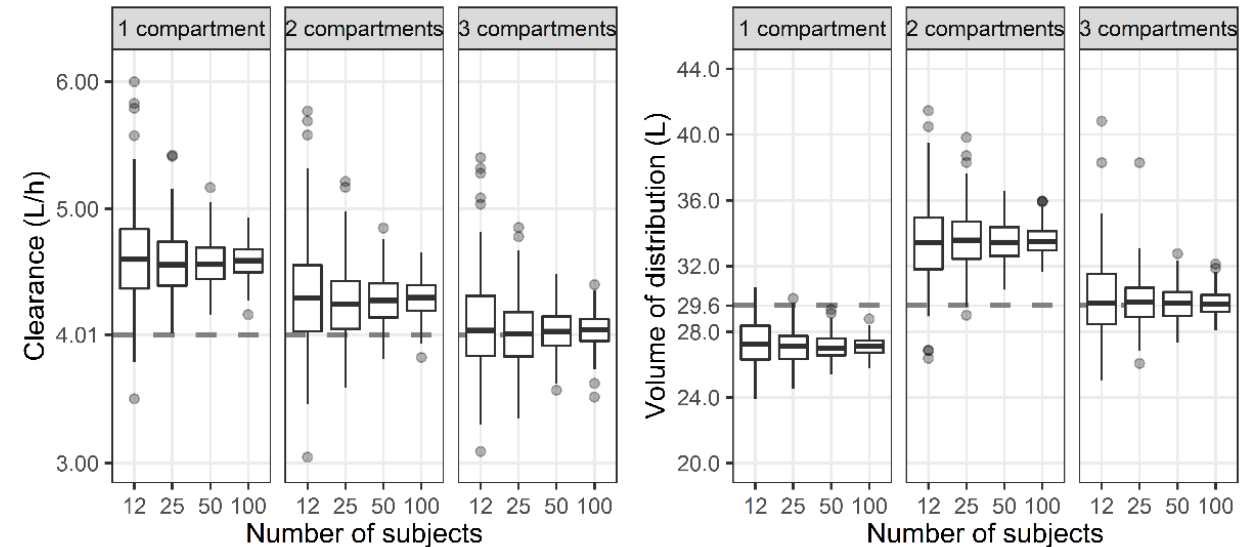
Figure 3. Distribution of total clearance and steady-state volume of distribution when one-, two-, and three-compartment models were developed with three-compartment PK profile and sparse or dense sampling designs (dashed lines, typical parameter values used for simulation; horizontal line inside the box, median; ends of each box, upper and lower quartiles; whiskers, 1.5 × quartiles; grey dots, outliers). Table 2. Relative bias (RBias) and relative root mean square error (RRMSE) of total clearance and steady-state volume of distribution when the number of compartments for PK model is equal to or less than that for the initially developed